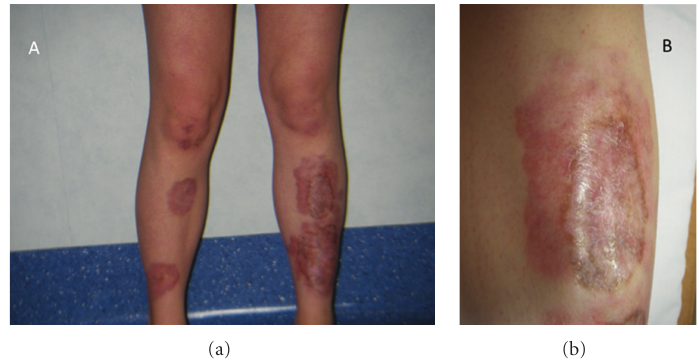
Figure 2: Skin lesions typically appear on the legs (a); particular of the skin lesions